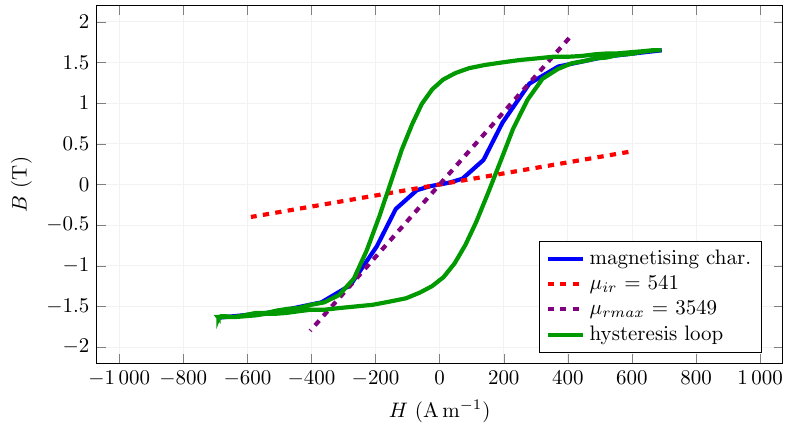
Figure 4. An example of the magnetic characteristics and hysteresis loop of Dramix 3D 55/30 B fibre, where µ ir is the initial relative permeability and µ rmax is the maximal relative